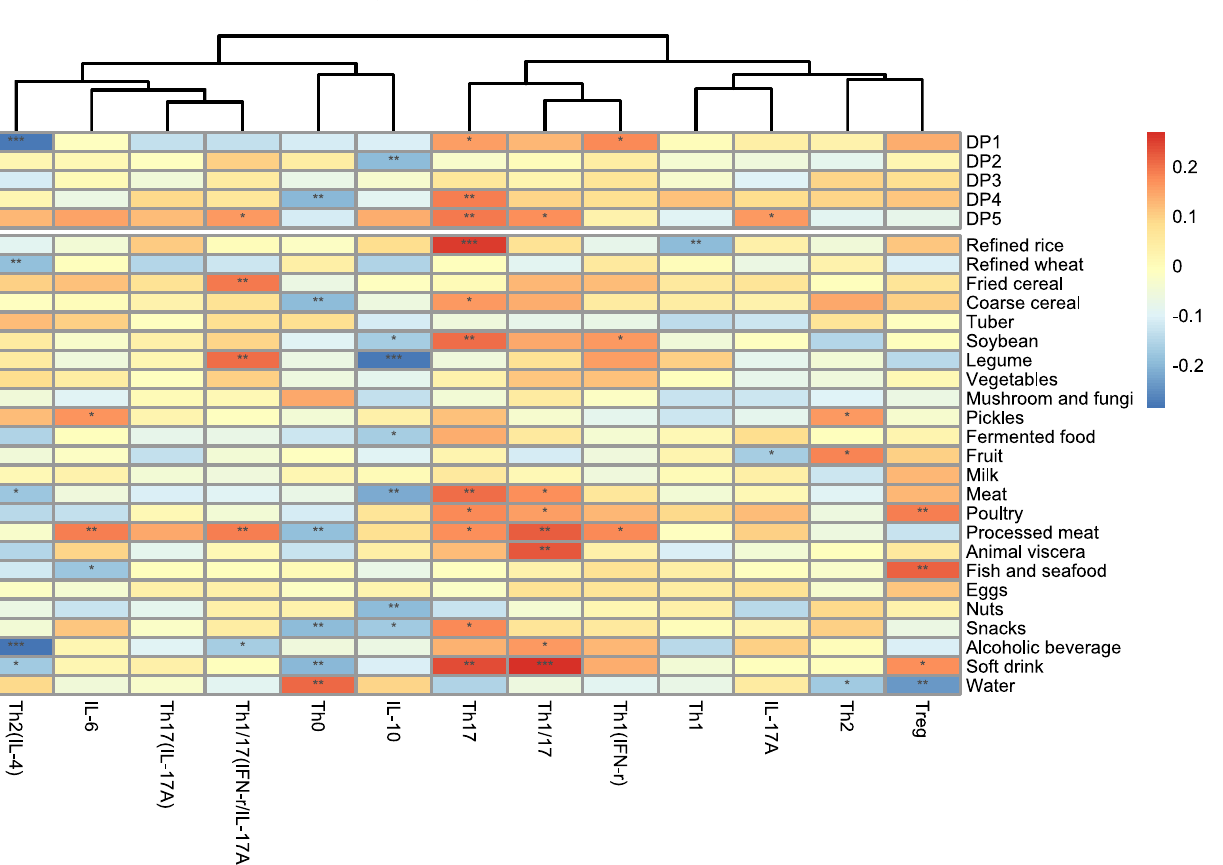
Figure 1. Correlation between food group and the subset (%) of CD4+ T cells. Correlation coefficient r > 0 was colored by red; r < 0 was colored by blue, * p < 0.1, ** p < 0.05, *** p <